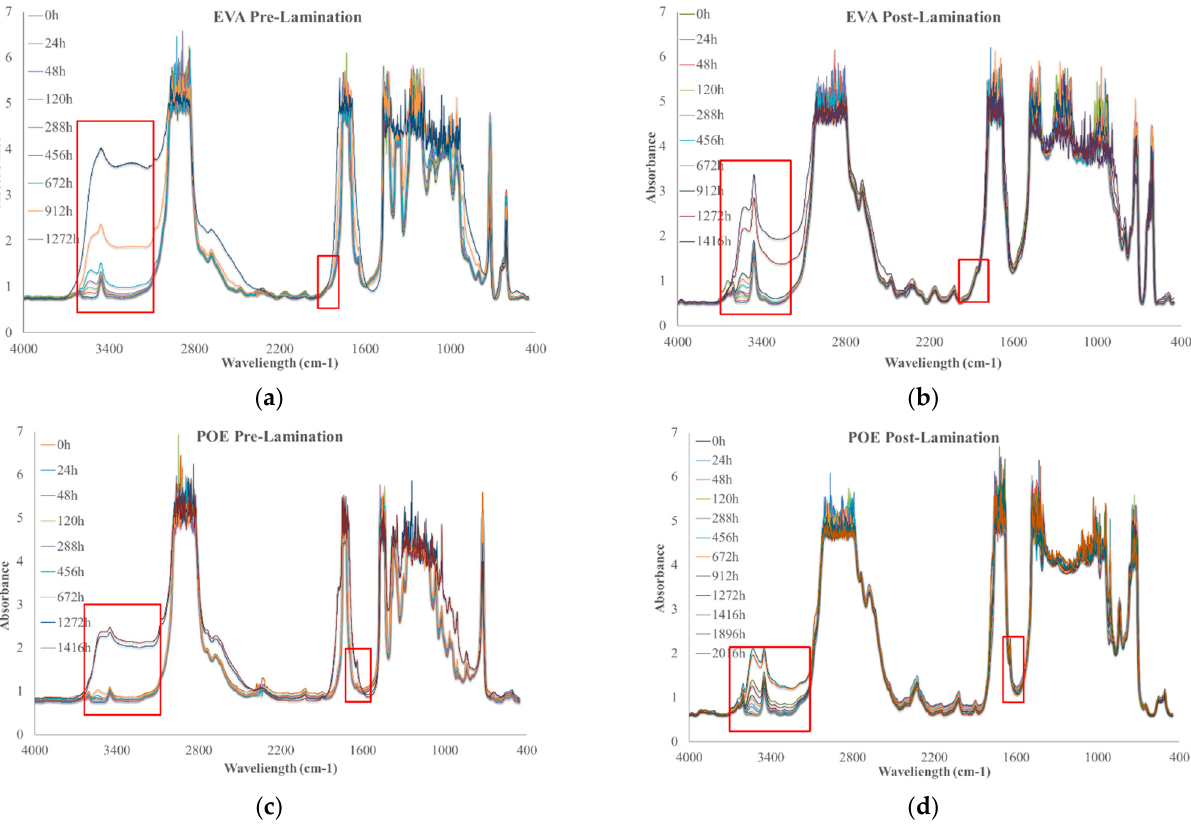
Figure 7. FTIR spectra of ( a ) EVApre-lam, ( b ) EVApost-lam, ( c ) POEpre-lam and ( d ) POEpost-lam commercial samples as a function of photo-oxidation time.